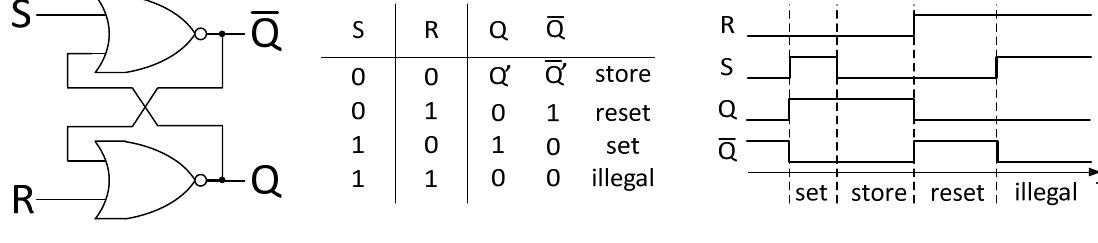
Figure 2. Original RS latch implementation utilizing NOR gates and its corresponding truth